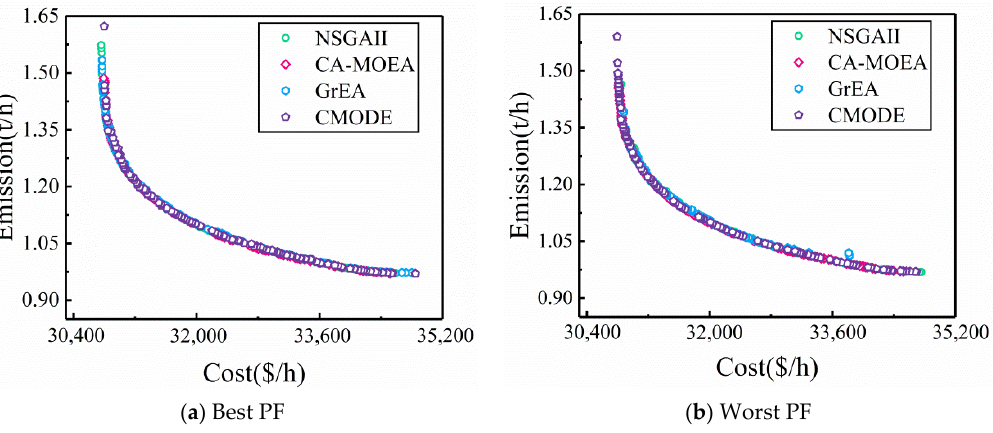
Figure 6. The comparison of the PFs of all methods in case 1.